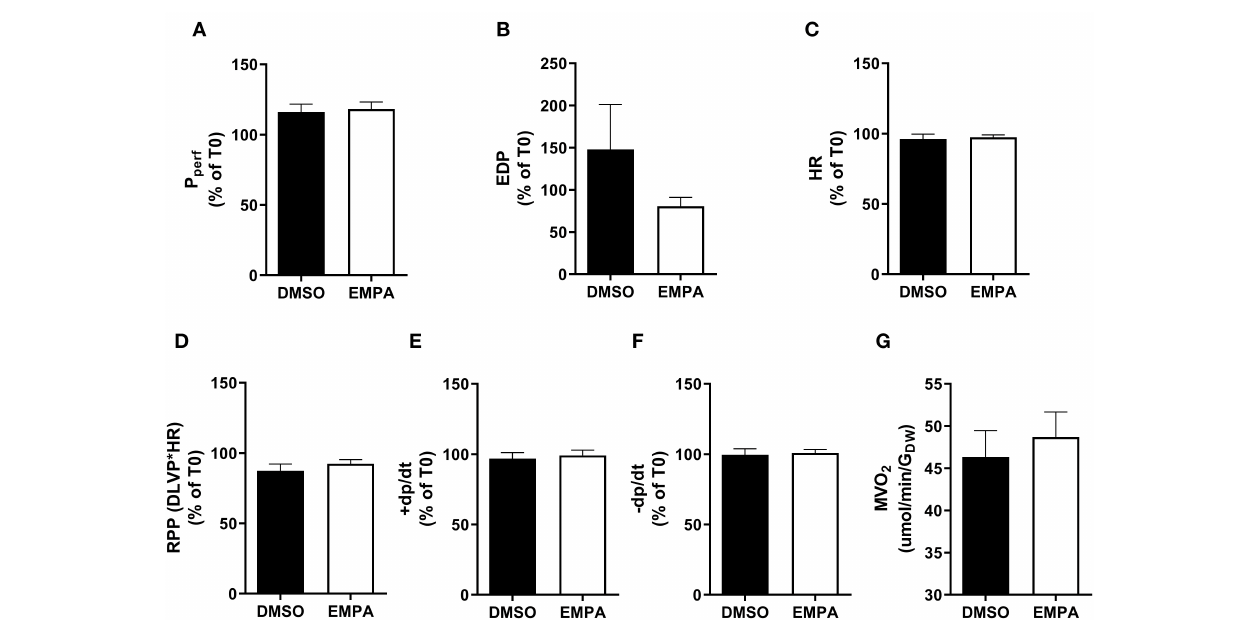
FIGURE 1 | EMPA’s effects on heart function and oxygen consumption with 13 C-glucose in perfusate in group 1. For all cardiac function parameters, the change at T = 35min relative to the value at T = 0min is depicted. (A) Perfusion pressure (P perf ), (B) end diastolic pressure (EDP), (C) heart rate (HR), (D) rate pressure product (RPP); DLVP, developed left ventricular pressure, (E) maximum contraction rate of left ventricle ( + dp/dt), and (F) maximum relaxation rate of left ventricle (-dp/dt), (G) oxygen consumption rate (MVO 2 ) determined at 25min perfusion. N = 16 for DMSO and n = 16 for EMPA. All values represent mean ± SEM.